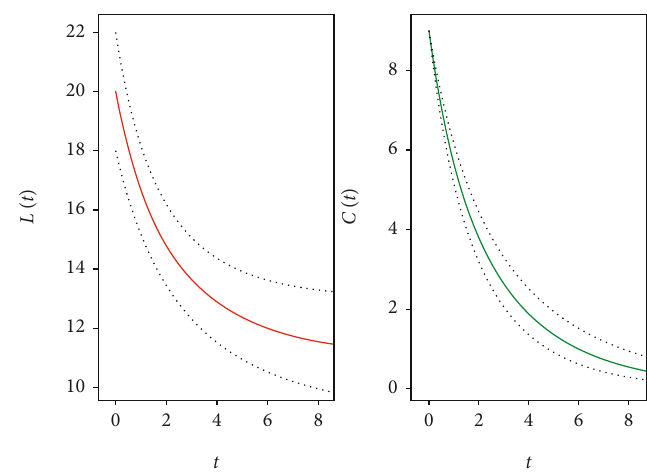
Figure 3: Functions L ð t Þ and C ð t Þ , α = 10 % .